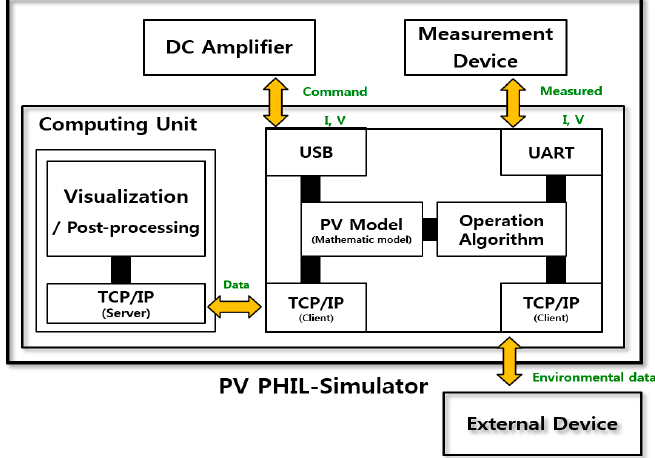
Figure 7. Architecture and data interface of the proposed PV Power Hardware-In-the-Loop (PHIL) simulator. USB: universal serial bus.